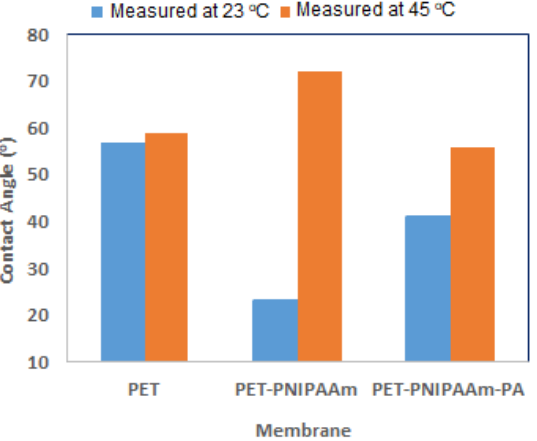
Figure 4. Water contact angle (WCA) values of